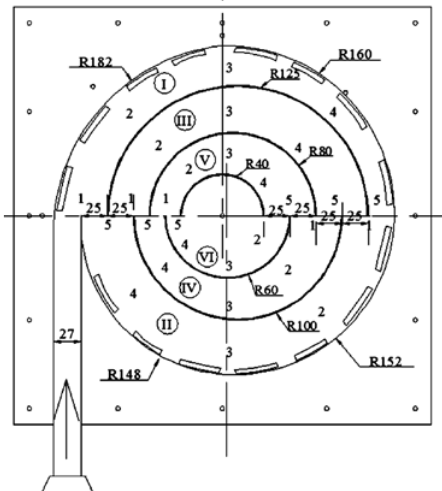
Fig. 6. The top view of the cylinder part of cyclone separator, 5 measurement points in each of the six channels